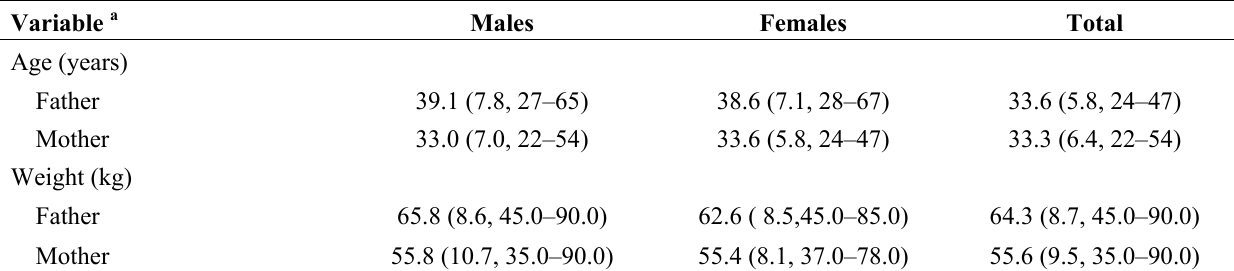
Table A2. Socioeconomic characteristics of parents of the study